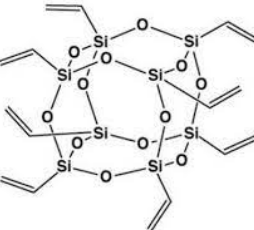
Figure 8. Spatial structure of (octavinyl—polyhedral oligomeric sisesquioxane) POSS. Rosemary extract was obtained in our laboratory by extraction from rosemary leaves. The powders of quercetin, capsaicin ( ≥ 95%, from Capsicum sp.) and oleanolic acid ( ≥ 97%) (see below their structures) were also provided by Sigma Aldrich (Figure 9).